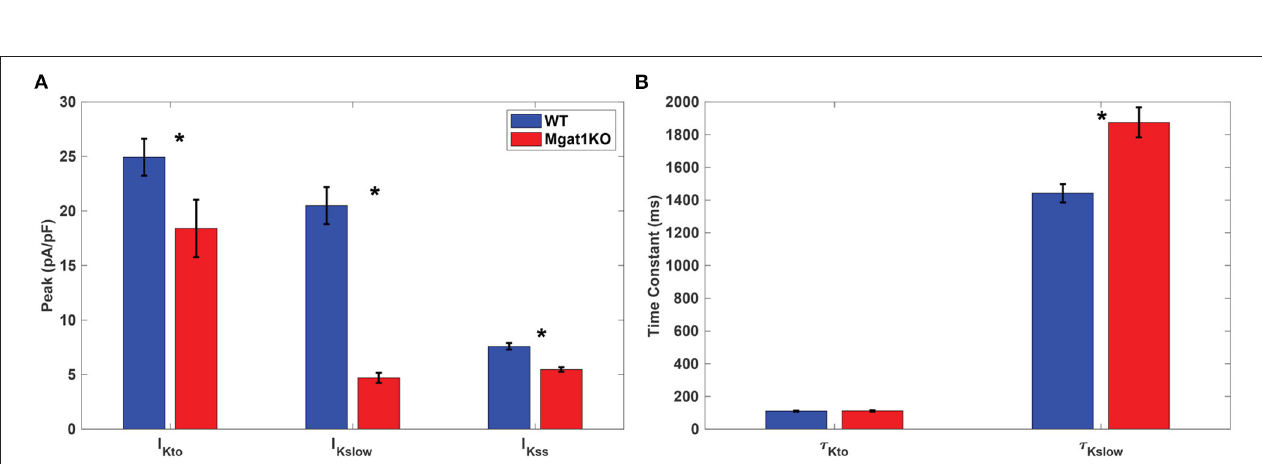
FIGURE 3 | In-vitro experimental results, adopted from Ednie et al. (2019b). (A) Averages and error bars of the peaks of I Kto and I Kslow , and steady-state amplitude of I Kss . (B) Inactivation time constant of I Kto and I Kslow . Significant differences between WT and Mgat1KO at p ≤ 0.05 are indicated by an *. ( n = 35 for WT and n = 38 for Mgat1KO).